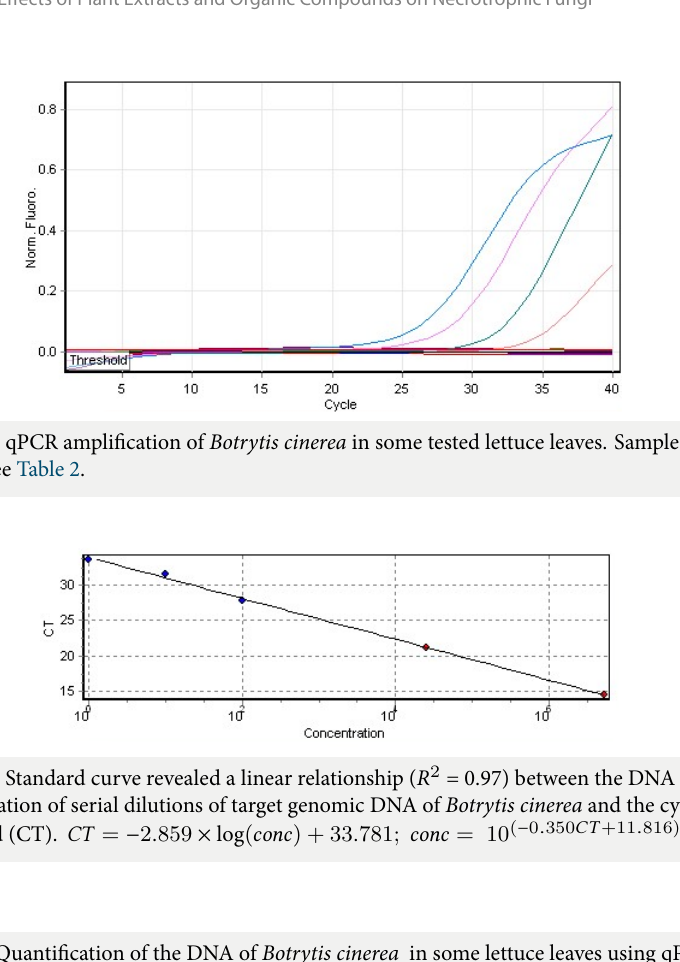
Table 2 Quantification of the DNA of Botrytis cinerea in some lettuce leaves using qPCR. Sample color Sample code CT Botrytis DNA